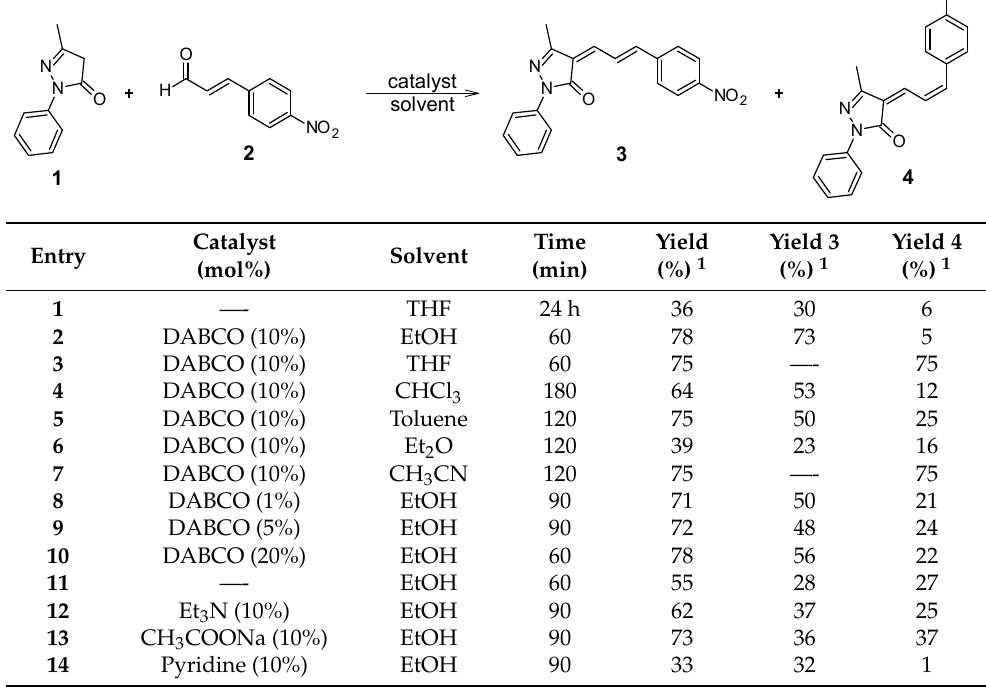
Table 1. Optimization of the Reaction Conditions.